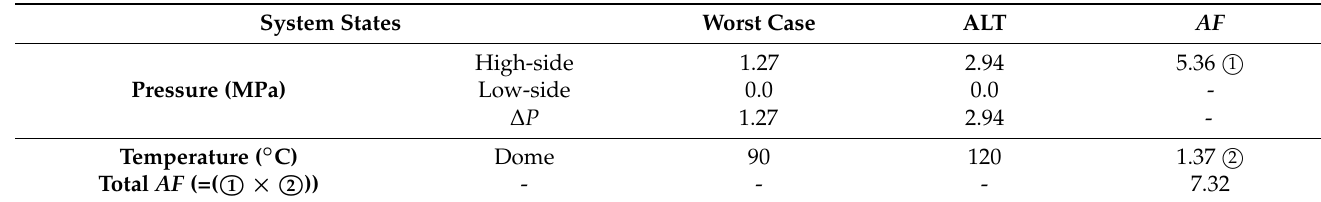
Table 3. Compressor ALT conditions.